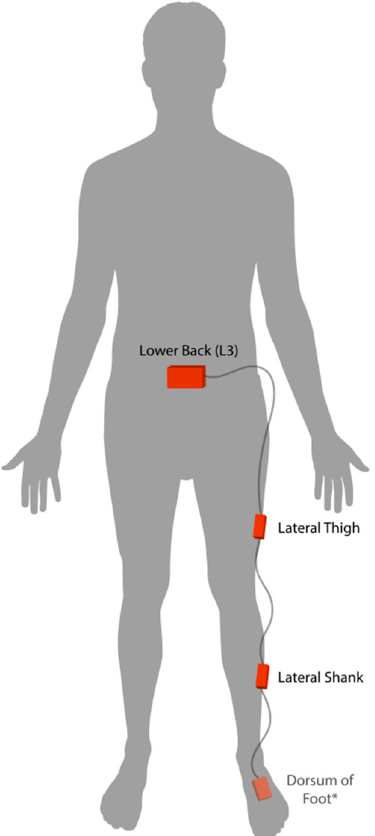
Figure 1. Placement of inertial sensors on the most affected side of knee osteoarthritis patients. * Sensor on the dorsum of the foot was only used for event detection and gait cycle segmentation.